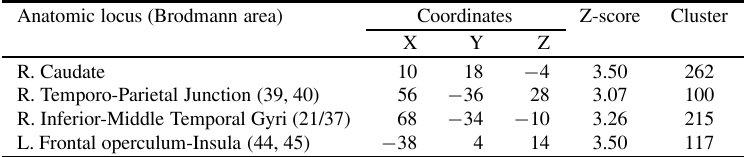
Table 4 Voxel-based morphometry results (masked by atrophy) in the bvFTD sample showing the areas of atrophy signi fi cantly related to Apathy Evaluation Scale ratings by caregivers Anatomic locus (Brodmann